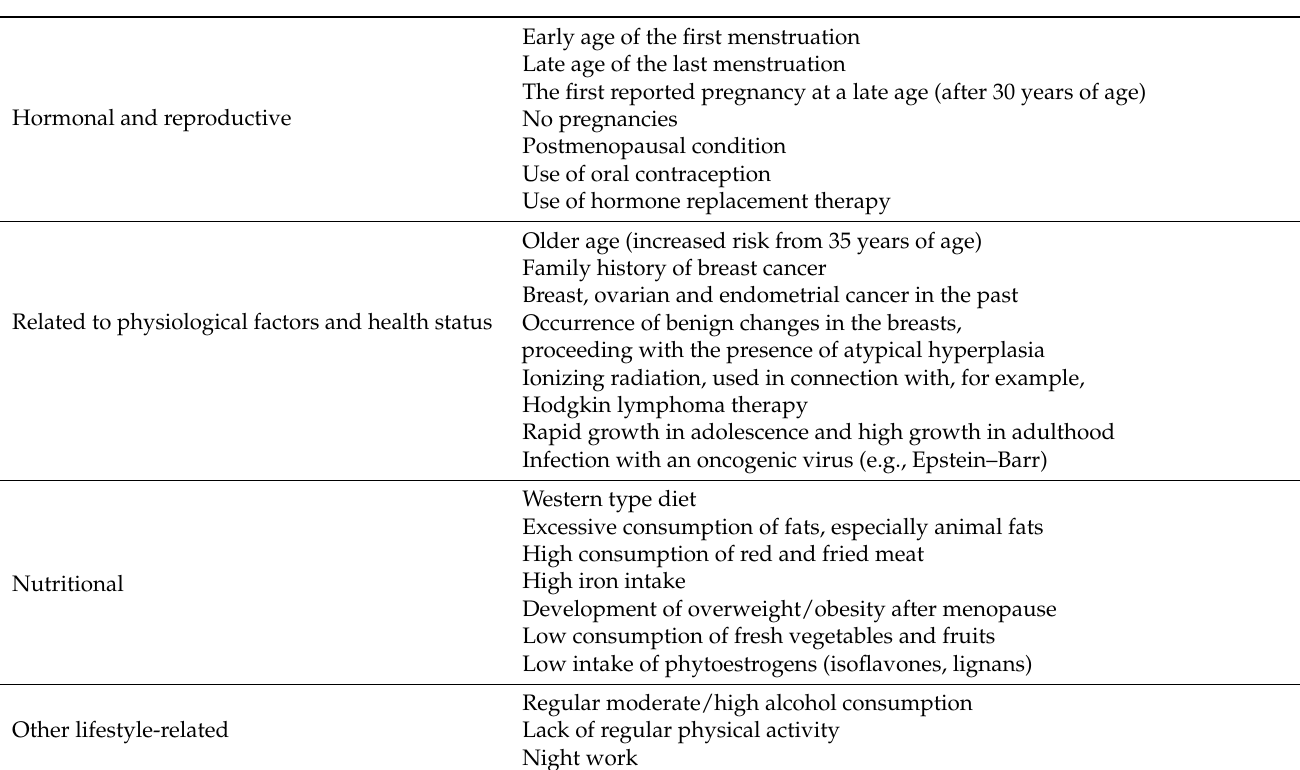
Table 1. Risk factors for breast cancer